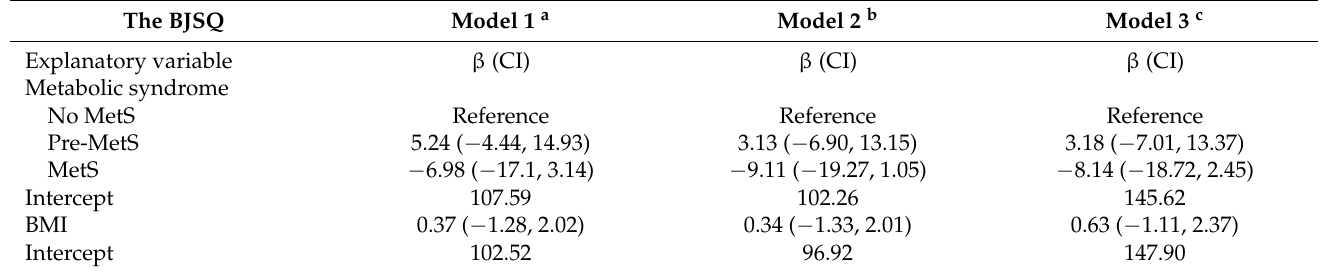
Table 5. The association between metabolic syndrome and body mass index, respectively, and